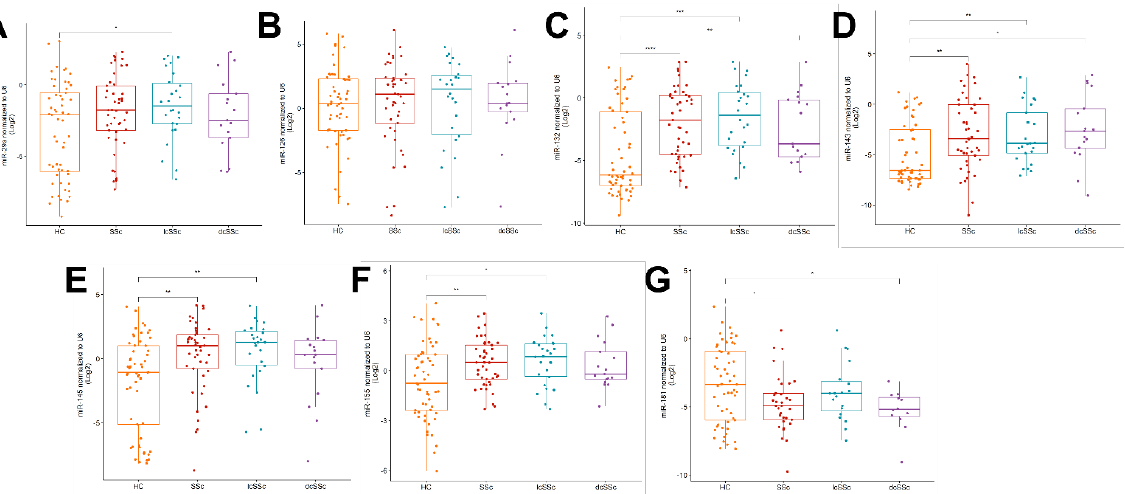
Figure 1. Expression of ( A ) miR–29a; ( B ) miR–126; ( C ) miR–132; ( D ) miR–143; ( E ) miR–145; ( F ) miR–155; ( G ) miR–181a in serum in healthy controls (HCs), systemic sclerosis (SSc) and the subtypes of SSc, limited systemic sclerosis (lcSSc) and diffusive systemic sclerosis (dcSSc). Data are presented with the median as the scattered boxplot graph. Pairwise posthoc significant differences: * p < 0.05; ** p < 0.01; *** p < 0.001; **** p <